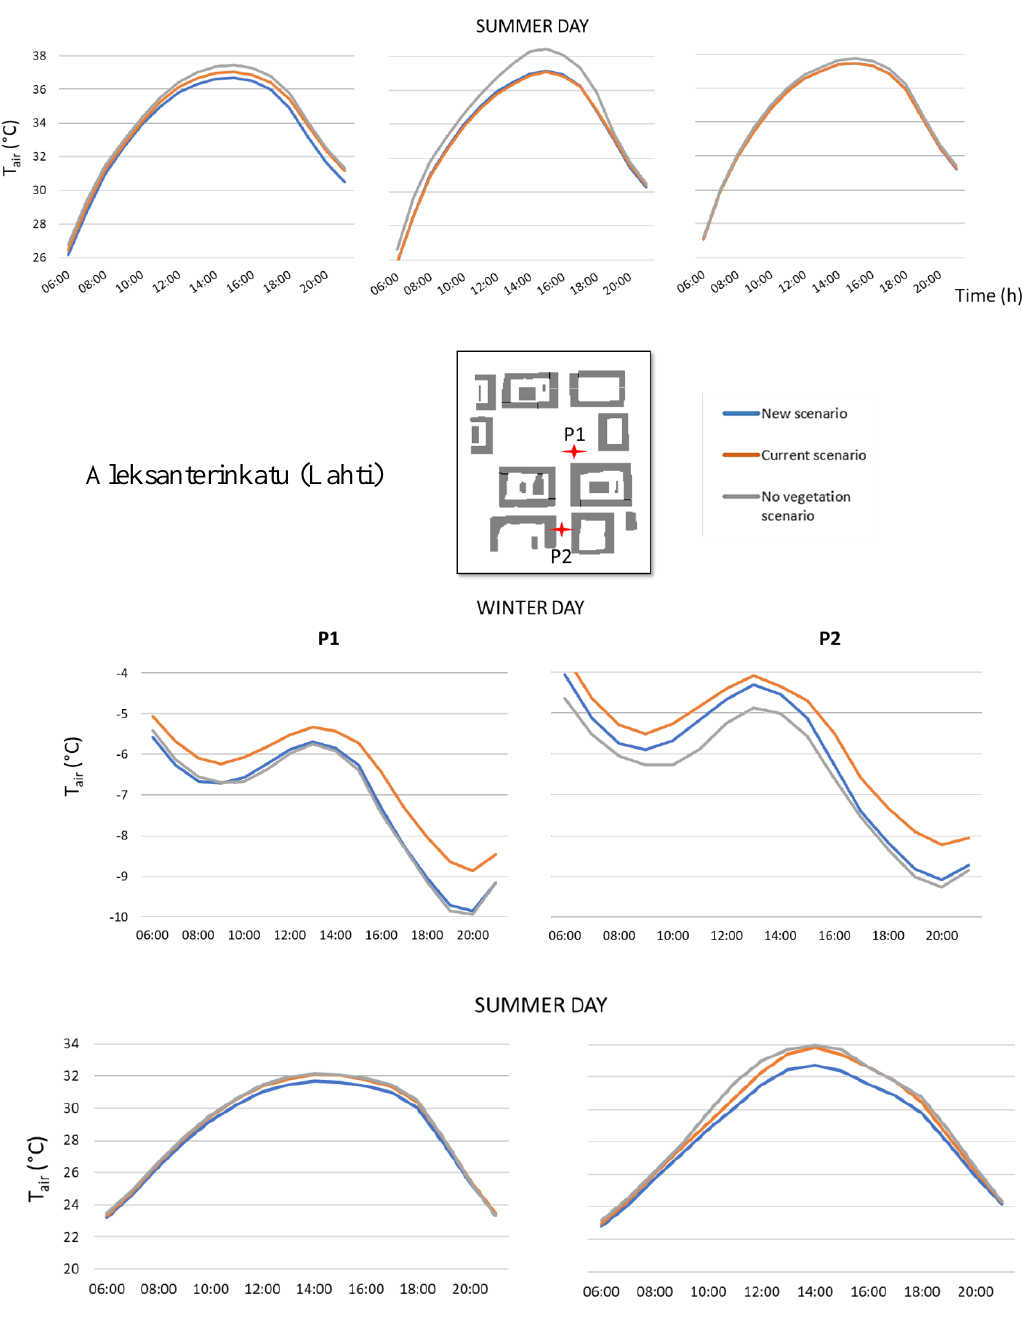
Figure 6. Profiles of air temperature T air obtained at points P1, P2 and P3 in San Pio (top) and P1 and P2 in Aleksanterinkatu (bottom) in the investigated summer and winter days. The extraction data points are indicated with a red star in the maps.